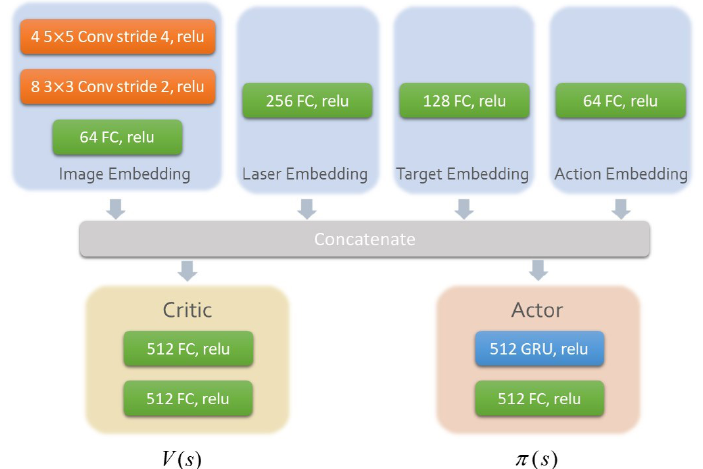
Figure 2. Description of our network structure.